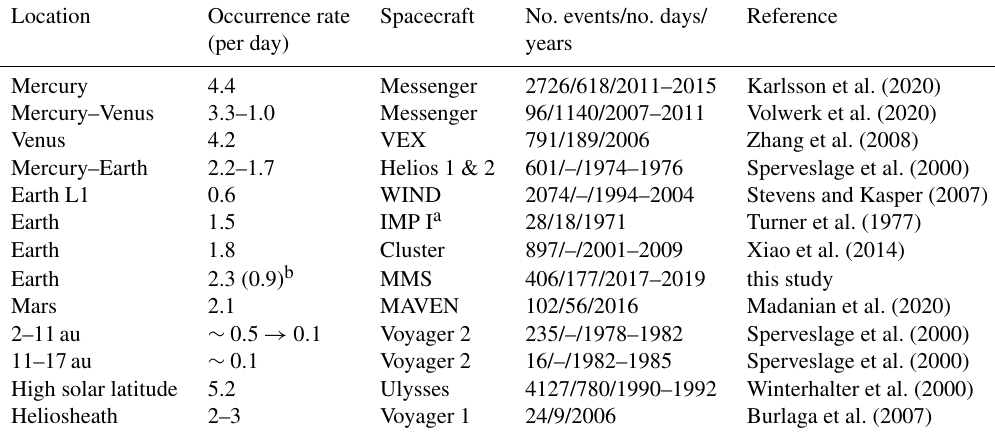
Table 1. Occurrence rates of magnetic holes in the solar wind throughout the system. Location Occurrence rate